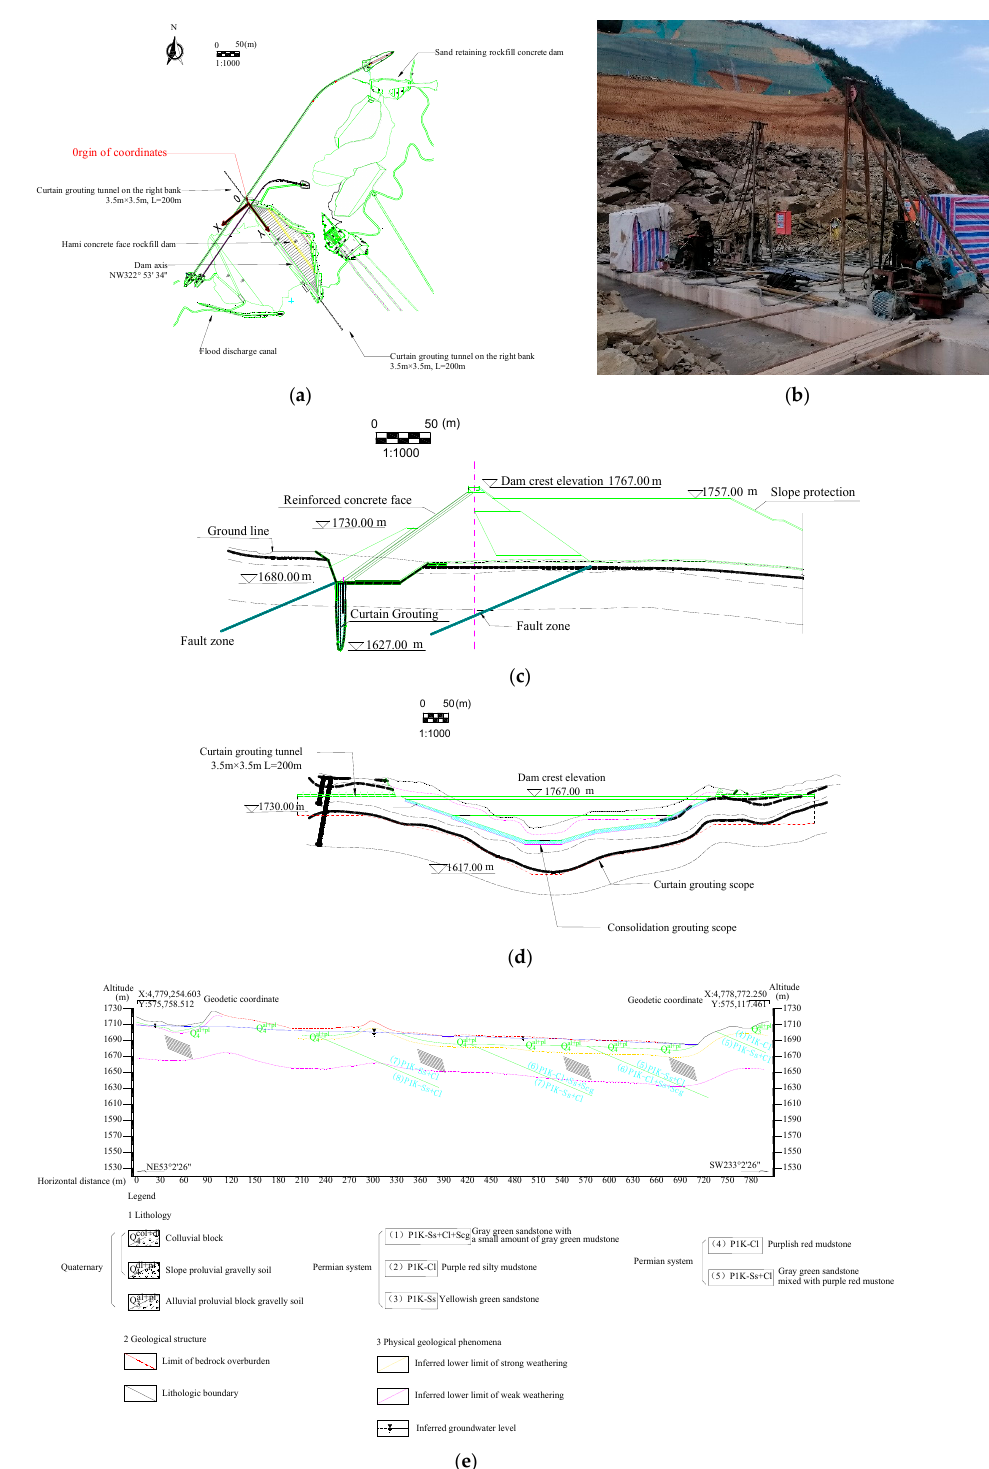
Figure 5. Hami concrete-face rockfill dam schematic diagram. ( a ) The vertical view. ( b ) Photos of the grouting curtain construction site. ( c ) The standard sectional view. ( d ) The view of the dam unfolding along the dam axis. The coordinate origin of the simulation model is marked in red. ( e ) Geological structure of the standard sectional view. The calculation scope of the three-dimensional finite element model of the natural period of the dam should include all the positive measurement points of the drilling water pressure near the dam in the geological exploration. The calculation range of the three- dimensional finite element model during the dam operation period should be more than twice the dam height (174 m). The model scope of the Hami dam in the operation period was extended to cover its upstream sand-retaining dam, which was larger than the calcu- lation area in the natural period. In addition, since the fault near the dam greatly influ- enced its seepage field, the calculation scope of the model was appropriately extended to the fault area nearby. The model above the groundwater level in the extended part was simplified because the terrain above the groundwater level did not affect the seepage field near the dam. The model’s coordinate origin and axis direction are shown in Figure 5a. Its earth geodetic coordinates are (x, y) = (575,654.299, 4779,524.6173). In the coordinate sys- tem of our model, the X axis is along the river, which is perpendicular to the dam axis, and the direction pointing downstream is positive; the Y axis is along the dam axis, and it is positive when it points to the left bank; and the Z axis is vertical, taking the elevation as the coordinate. The upstream and downstream boundaries are, respectively, intercepted at 140 m above the upstream slope toe of the lower reservoir barrage and 330 m below the downstream slope toe. The left and right bank boundaries are intercepted at 800 m to the left and 110 m to the right of the right dam abutment. The top elevation is based on the actual terrain, and the bottom elevation reaches 1500 m a.s.l. The area of the dam model in the natural period was –265 m < x < 350 m, –110 m < y < 675 m, and 1500 m < z . The area of the dam model in the operation period was –920 m < x < 540 m, –110 m < y < 1200 m, and 1500 m < z . Table 2 shows the natural period’s groundwater head ( E M ) of the Hami dam’s 12 drilling points in the geological exploration. Table 2. Drilling water head E M in the geological exploration. Number